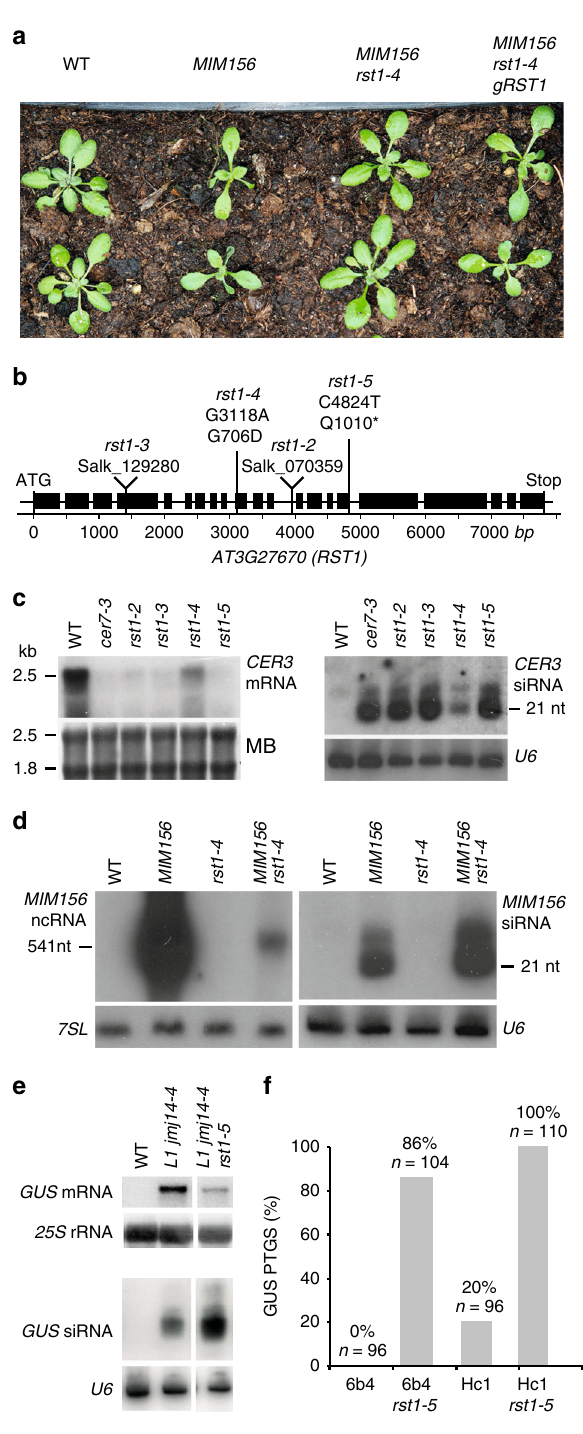
siRNA similar to rst1-2 and rst1-3 (Fig. 2c). To further demonstrate that rst1-5 enhances PTGS, we introduced the rst1-5 mutation into the well-established reporter lines 6b4 and Hc1 57 (Fig. 2f). These lines harbour the same 35S:GUS transgene as the L1 jmj14-4 line, but inserted at different locations in the Arabidopsis genome. In a wild-type background, line 6b4 does not trigger sense transgene PTGS (S-PTGS), while line Hc1 triggers S- PTGS in 20% of the population (Fig. 2f). In genetic backgrounds having impaired RNA degradation, both Hc1 and 6b4 lines trigger S-PTGS at increased frequencies, which provides a quantitative readout 25,55 – 57,59,63 . 86% of the 6b4 rst1-5 plants and 100% of the Hc1 rst1-5 plants triggered silencing of the 35S: GUS reporter (Fig. 2f). This result con fi rmed that RST1 functions as a suppressor of S-PTGS comparable with other proteins involved in RNA degradation 25,55 – 57,59,63 . Of note, the role of RST1 as S-PTGS suppressor is also supported by an independent study published during the reviewing process of our paper 64 . RST1 co-puri fi es with the exosome, SKI7 and RIPR . To examine the intracellular distribution of RST1, we used a rst1-3 mutant line expressing RST1 proteins fused to GFP at its N- or C- terminus. Both fusion proteins were functional as they rescued the wax de fi ciency of rst1-3 (Fig. 1), and showed a diffuse cytoplasmic distribution in root cells of stable Arabidopsis transformants similar to the cytoplasmic marker protein PAB2 (Fig. 3). There- fore, we conclude that RST1 is a cytoplasmic protein. The diffuse cytoplasmic localisation of RTS1 is in agreement with a recent independent study 65 . In our previous experiments, RST1 co- puri fi ed with Exo9 using the core exosome subunit RRP41 as bait 25 . To verify the association of RST1 with Exo9, we used GFP- RST1 or RST1-GFP as baits for immunoprecipitation (IP) The second screen directly aimed at identifying factors experiments followed by LC-MS/MS analyses (15 IPs). Indeed, affecting the post-transcriptional silencing of the 35Sprom:GUS amongst the proteins that were enriched in RST1 IPs were the transgene in the reporter line L1 jmj14-4 62 . This screen identi fi ed nine canonical subunits of Exo9: CSL4, MTR3, RRP4, RRP40A, rst1-5 , a C4824T mutation in RST1 resulting in a truncation of the RRP41, RRP42, RRP43, RRP45B/CER7 and RRP46 (Fig. 4a; RST1 protein (Q1010*) (Fig. 2b). Compared with the L1 jmj14-4 Supplementary Data 1). By contrast, we did not detect HEN2 or parental line, L1 jmj14-4 rst1-5 plants had decreased levels of GUS MTR4, the two main cofactors of nucleoplasmic or nucleolar mRNA and increased levels of GUS -derived siRNA (Fig. 2e). This exosomes, respectively. Noteworthy, RST1 co-puri fi ed with the result resembled the effects of rst1-4 on the accumulation of cytoplasmic protein encoded by AT5G10630 , the mRNA of which MIM156 transcript and MIM156- derived siRNAs (Fig. 2d). is alternatively spliced to produce either HBS1 or SKI7 proteins. As compared with the HBS1 mRNA, the SKI7 mRNA contains an which showed a pronounced accumulation of CER3 -derived additional exon encoding the putative exosome interaction NATURE COMMUNICATIONS| (2019) 10:3871